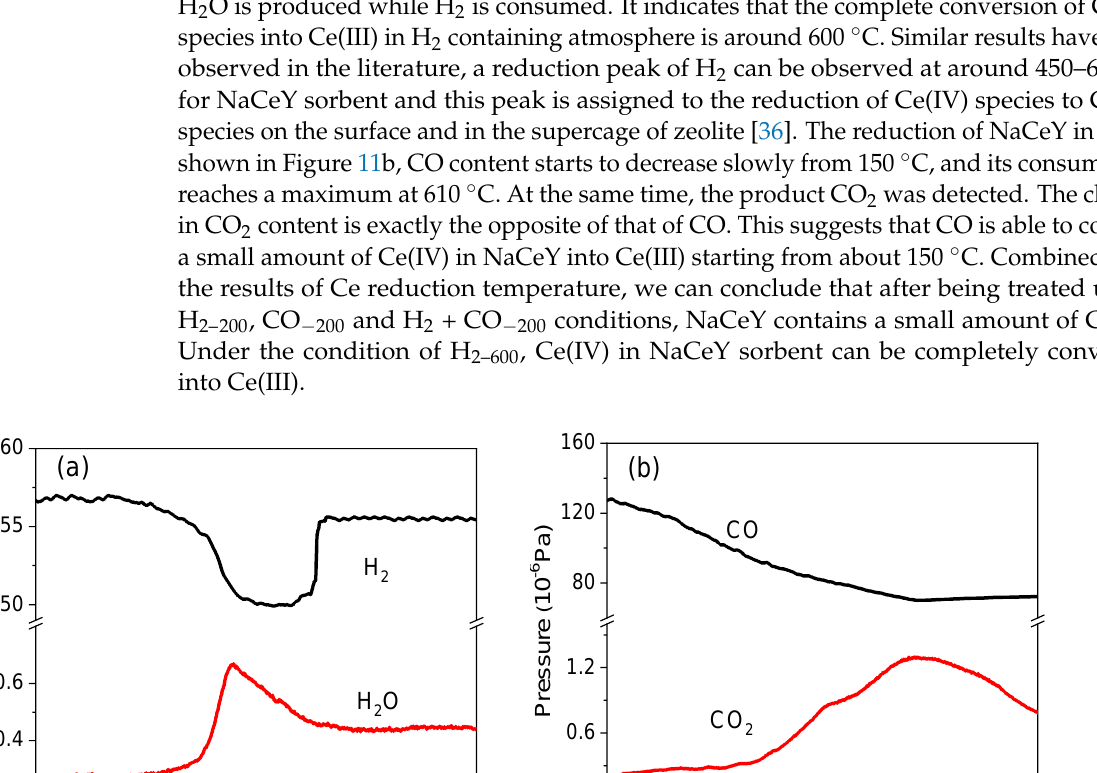
thiophene of NaCeY are shown in Figure 12a,b, respectively. Compared with the Q b-thiophene of NaCeY containing totally Ce(IV) (57.6 mg/g, Figure 10b), the Q b-thiophene of NaCeY contain- ing part of Ce(III) ranges from 13.6 mg/g to 19.0 mg/g. Significantly, the Q b-thiophene of NaCeY containing only Ce(III) is 4.96 mg/g, which is 8.61% of the highest Q b-thiophene of NaCeY. Therefore, it can be concluded that the adsorption capacity of Ce(IV) species in NaCeY for thiophene is much better than that of Ce(III).